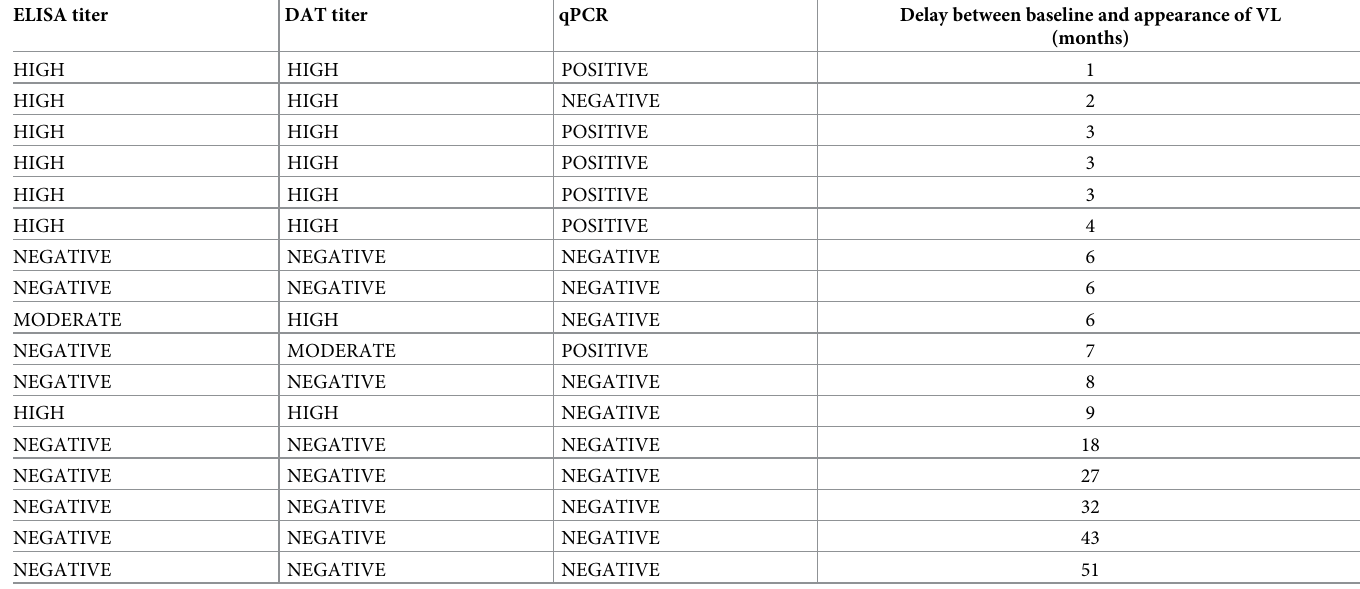
Table 2. Delay between baseline screening and time of onset of disease for 17 VL casesin relation to their initial DAT, rK39 and qPCR status. ELISA titer DAT titer qPCR Delay between baseline and appearance of VL